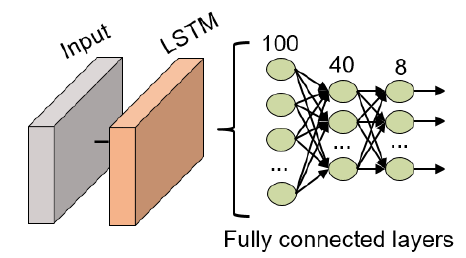
Figure 11. LSTM NN structure for gesture recognition.